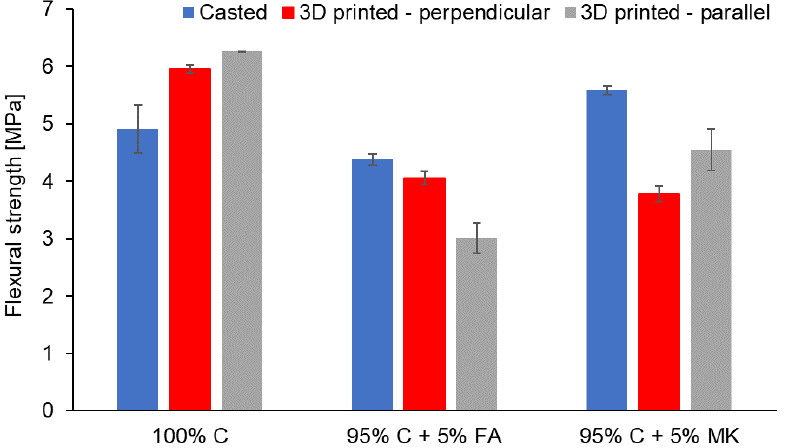
Figure 3. The flexural strength of concrete (100% C) and concrete-geopolymer hybrids based on fly ash (95% C + 5% FA) and metakaolin (95% C + 5% MK) that were cast and 3D printed. For 3D printed samples, the analysis was performed in the parallel and perpendicular direction to the Z -axis of the printout.